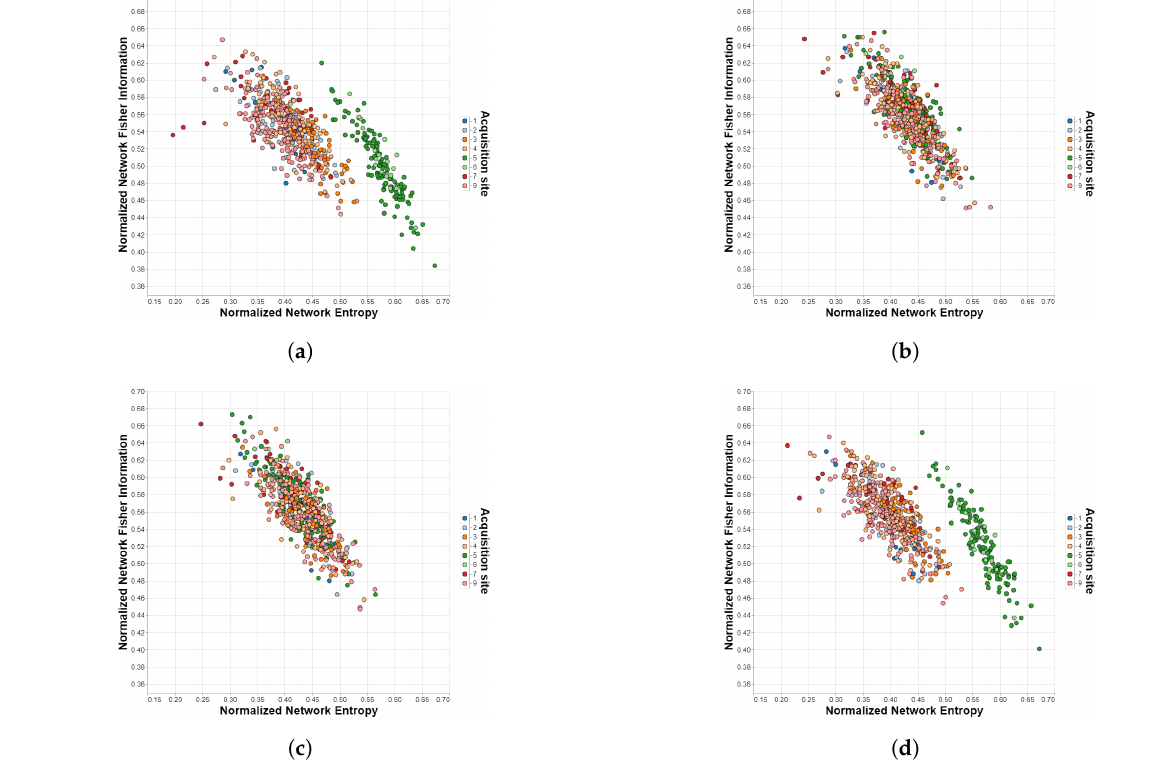
Figure 4. Shannon − Fisher planes for SRPBS with different harmonization methods. Each point corresponds to a different subject in the dataset and each color to a different acquisition site.